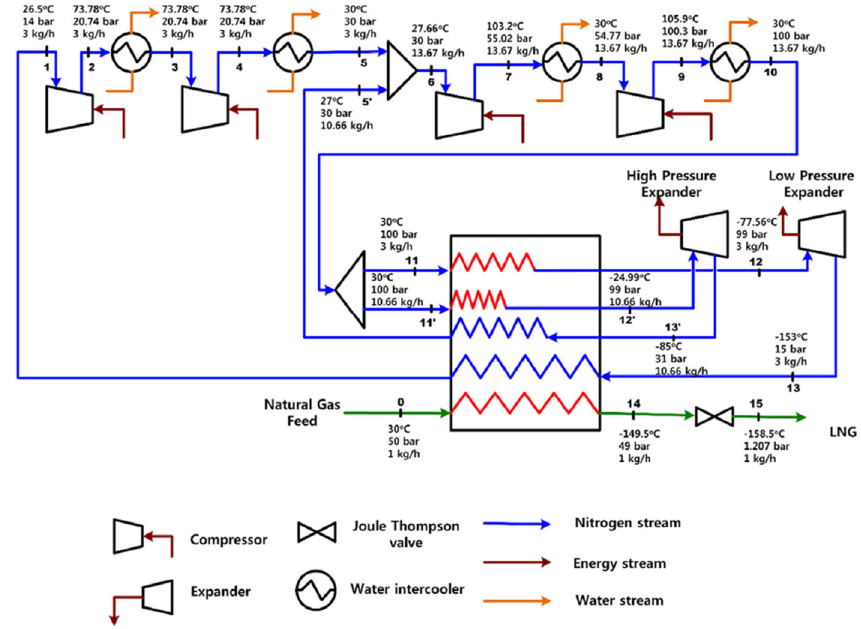
Figure 15. Process flow for boil-off gas (BOG) re-liquefaction nitrogen expansion liquefaction pro- cess [57]. Reproduced with permission from Elsevier (license number